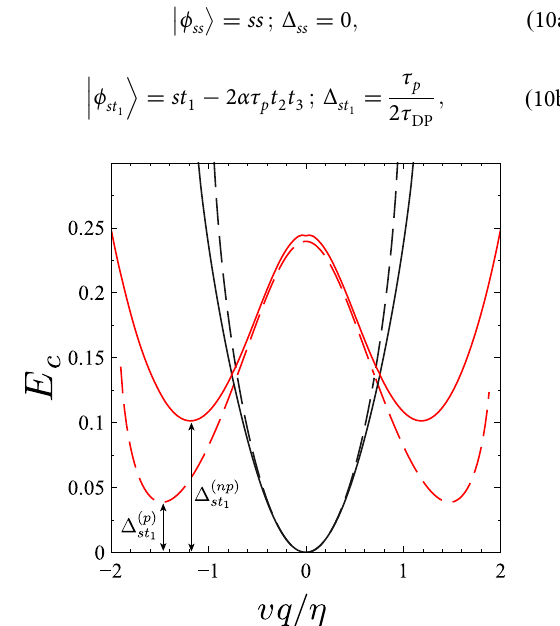
Fig. 3 Perturbative versus non-perturbative treatment of the Cooperon Hamiltonian ’ s dispersion relations. Comparison of the ss (black) and st 1 (red) transport modes' dispersion relations, E c ( q ), calculated via perturbative (dashed) and non-perturbative (solid) methods. We see that signi fi cant minima develop in the st 1 mode away from the origin, which are underestimated by perturbative approaches ( Δ ð np Þ st ε = 0.2 eV, η = 0.7 meV and α = 2 η /3 for the Fermi energy, quasiparticle broadening, and Rashba coupling strength